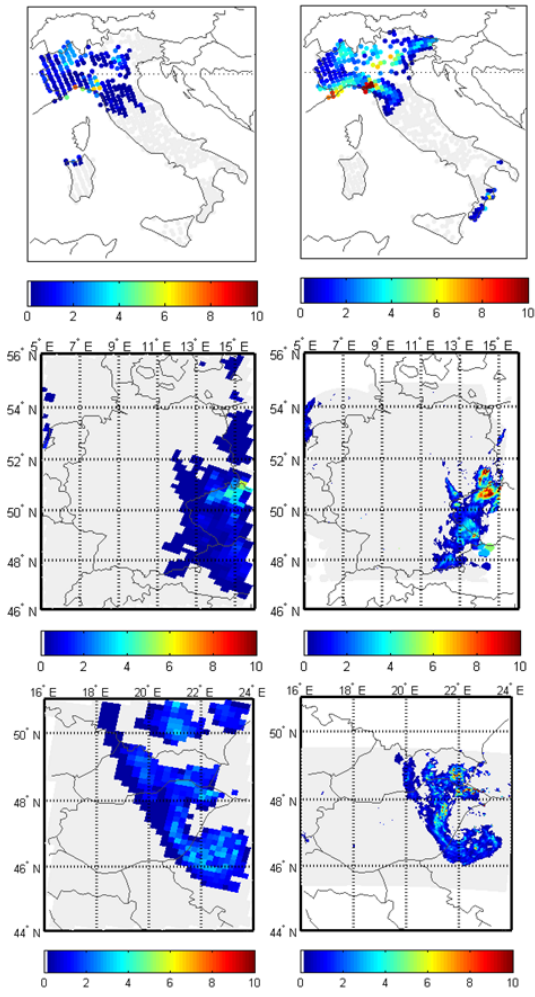
Figure 11. Comparison between H-SAF product H02 v2.3 (left panels) and ground-based measurements (right panels). Top panels: flood over the La Spezia area (Italy, 44 ◦ N, 10 ◦ E), 25 October 2011, 11:44UTC. H02 v2.3 surface precipitation rate (mmh − 1 ) over land (left), and 1h cumulated precipitation (11:00–12:00UTC) from rain gauges, spatially averaged and sampled (right). Middle panels: con- vective precipitation over Germany, 7 August 2010, 09:51UTC. H02 v2.3 surface precipitation rate (mmh − 1 ) (left), and radar rainfall rate estimate (mmh − 1 ) at high resolution at 09:50UTC (right). Bottom panels: thunderstorms over Hungary, 30 July 2011, 08:30UTC. H02 v2.3 surface precipitation rate (mmh − 1 ) (left) at 08:24UTC, and radar rainfall rate estimate (mmh − 1 ) at high reso- lution at 08:30UTC (right).